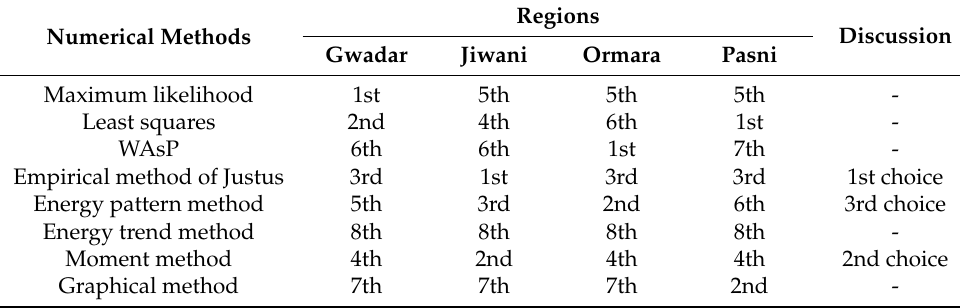
Table 8. Ranking by statistical test results for eight numerical